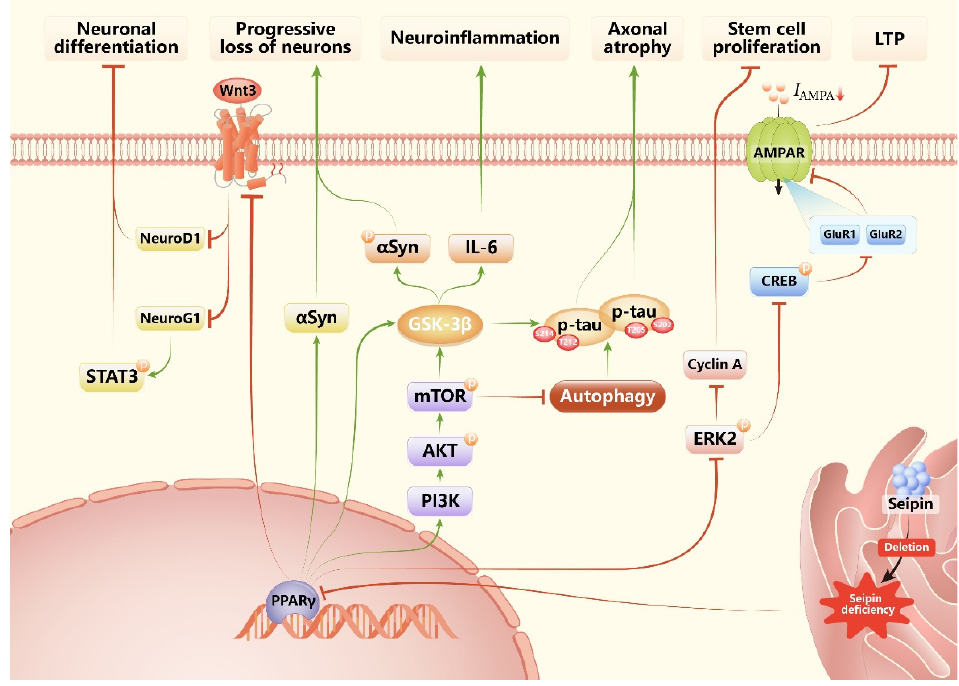
Figure 2. Summary of the mechanisms in neurons leading to neurodegenerative phenotypes in SKO mice and in seipin ‐ nKO mice. Seipin deficiency suppresses PPAR γ expression. Decreased PPAR γ inhibits neuronal differentiation via the Wnt3 pathway, promotes the phosphorylation and aggregation of α syn and tau protein and neuroinflammation through activating the PI3K/AKT/mTOR pathway and GSK ‐ 3 β pathway, and impairs stem cell proliferation and the current of AMPAR, as well as LTP via inhibiting ERK pathways. Abbreviations: PPAR γ : peroxisome proliferator activated receptor gamma; STAT3: signal transducer and activator of transcription 3; NeuroD1: neurogenic differentiation 1; Neurog1: neurogenin 1; α syn: α‐ synuclein; PI3K: phosphatidylinositol 3 ‐ kinase; AKT: protein kinase B; mTOR: mammalian target of rapamycin; GSK3 β : glycogen synthase kinase ‐ 3 β ; IL ‐ 6: interleukin ‐ 6; ERK2: extracellular signal ‐ regulated kinase 2; CREB: cAMP ‐ responsive element binding protein; GluR1: α‐ amino ‐ 3 ‐ hydroxy ‐ 5 ‐ methyl ‐ 4 ‐ isoxazolepropionic acid (AMPA) receptor subunits 1; GluR2: α‐ amino ‐ 3 ‐ hydroxy ‐ 5 ‐ methyl ‐ 4 ‐ isoxazolepropionic acid (AMPA) receptor subunits 2; AMPAR: α‐ amino ‐ 3 ‐ hydroxy ‐ 5 ‐ methyl ‐ 4 ‐ isoxazole propionic acid receptor; I AMPA : AMPA ‐ induced current; LTP: long ‐ term potentiation.